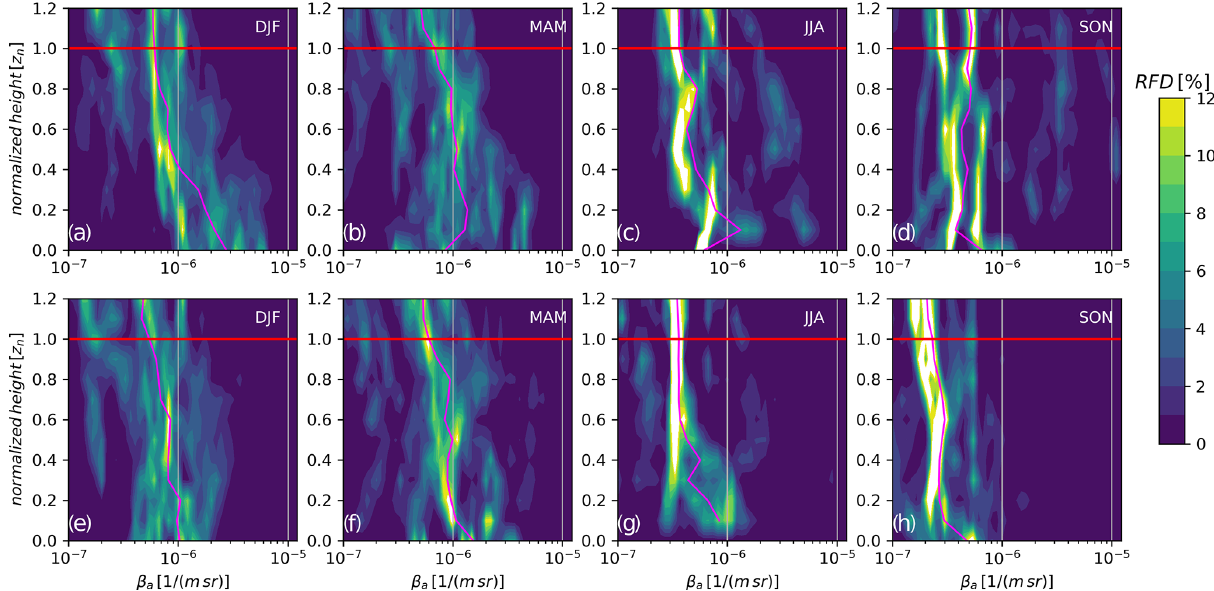
Figure 4. Relative frequency distributions (RFDs) [%, colors] of aerosol backscatter as a function of normalized height, z n , where z n = 0 is the surface and z n = 1 is the former/successive mean cloud top height surrounding the clear-sky period. All HSRL backscatter profiles after/before 60min of cloud dissipation/formation are combined to create the frequency distributions, which are normalized to 100% at each normalized height range. Seasonal distributions for DJF, MAM, JJA and SON are shown for (a–d) after cloud dissipation (start of clear period) and (e–h) prior to cloud formation (end of clear period). Median profiles for each season are given in magenta.